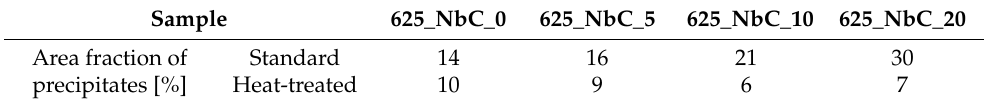
Table 8. Area fraction of precipitates in Inconel 625-NbC materials before and after heat